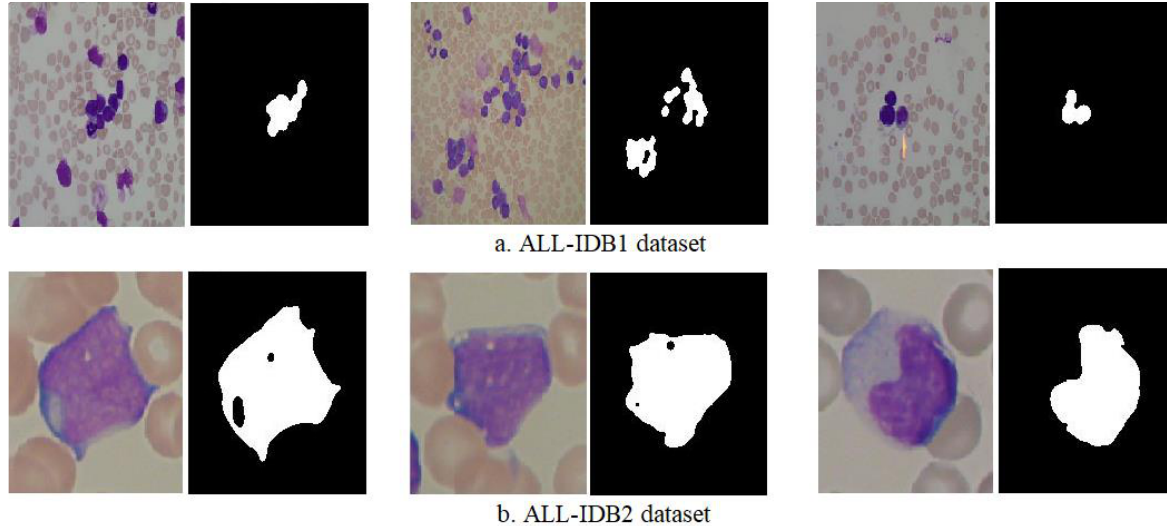
Figure 4. Samples from the two datasets after segmentation.